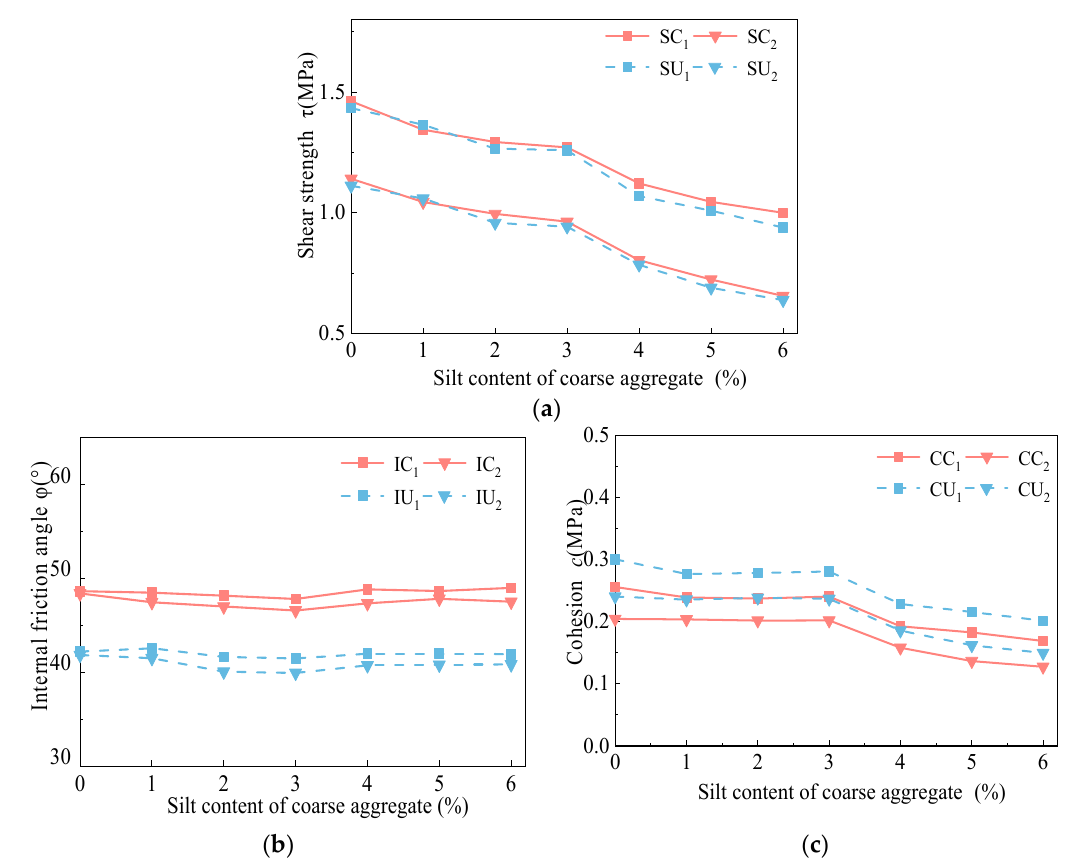
Figure 10. Shear strength, internal friction angle, and cohesion of coarse aggregate containing silt specimen before and after high-temperature immersion Marshall test. ( a ) Shear strength; ( b ) Internal friction angle; ( c ) Cohesion.